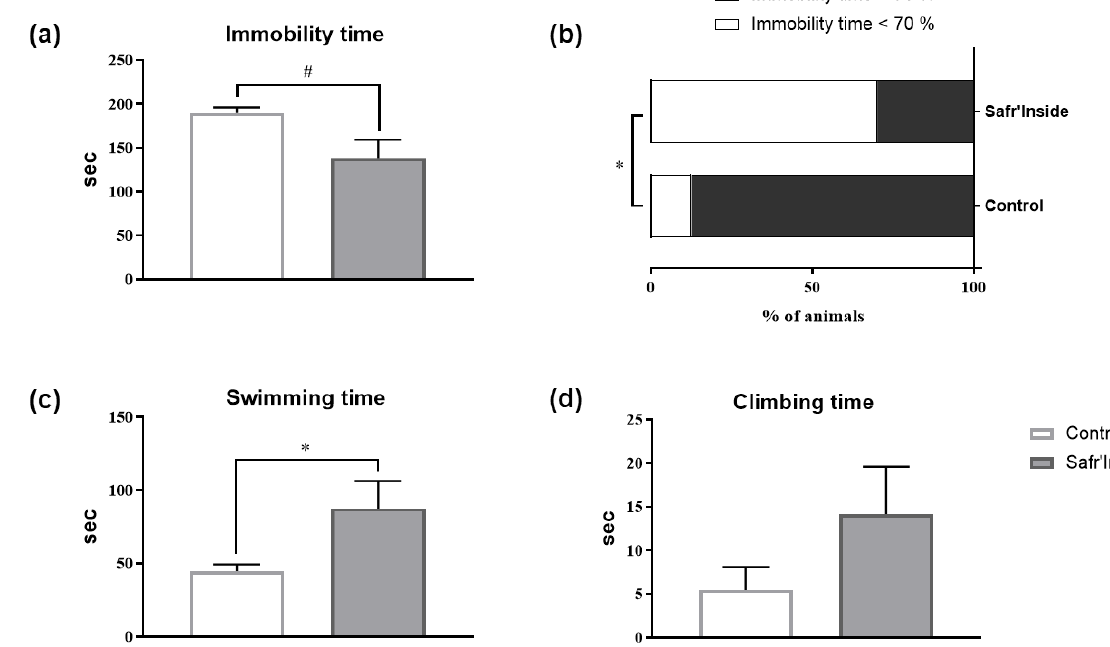
Figure 3. Effect of acute oral administration of Safr’Inside TM (6.25 mg/Kg) on depressive-like behavior measured in the FST. ( a ) Immobility time; ( b ) Index of immobility; ( c ) Swimming time and ( d ) Climbing time. FST has been conducted 30 min after gavage. Results are shown as mean ± SEM. Control (Water): n = 8; Safr’Inside: n = 10. # p = 0.05, * p <